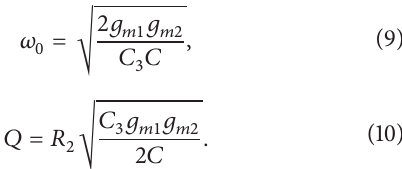
The expressions for pole- 𝜔 0 and 𝑄 are also modified and given in (9) and (10),